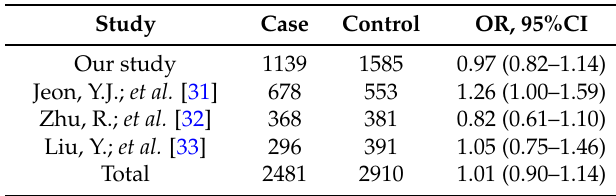
Table 7. Association between rs2910164 polymorphism and ischemic stroke incidence in Asian populations (four